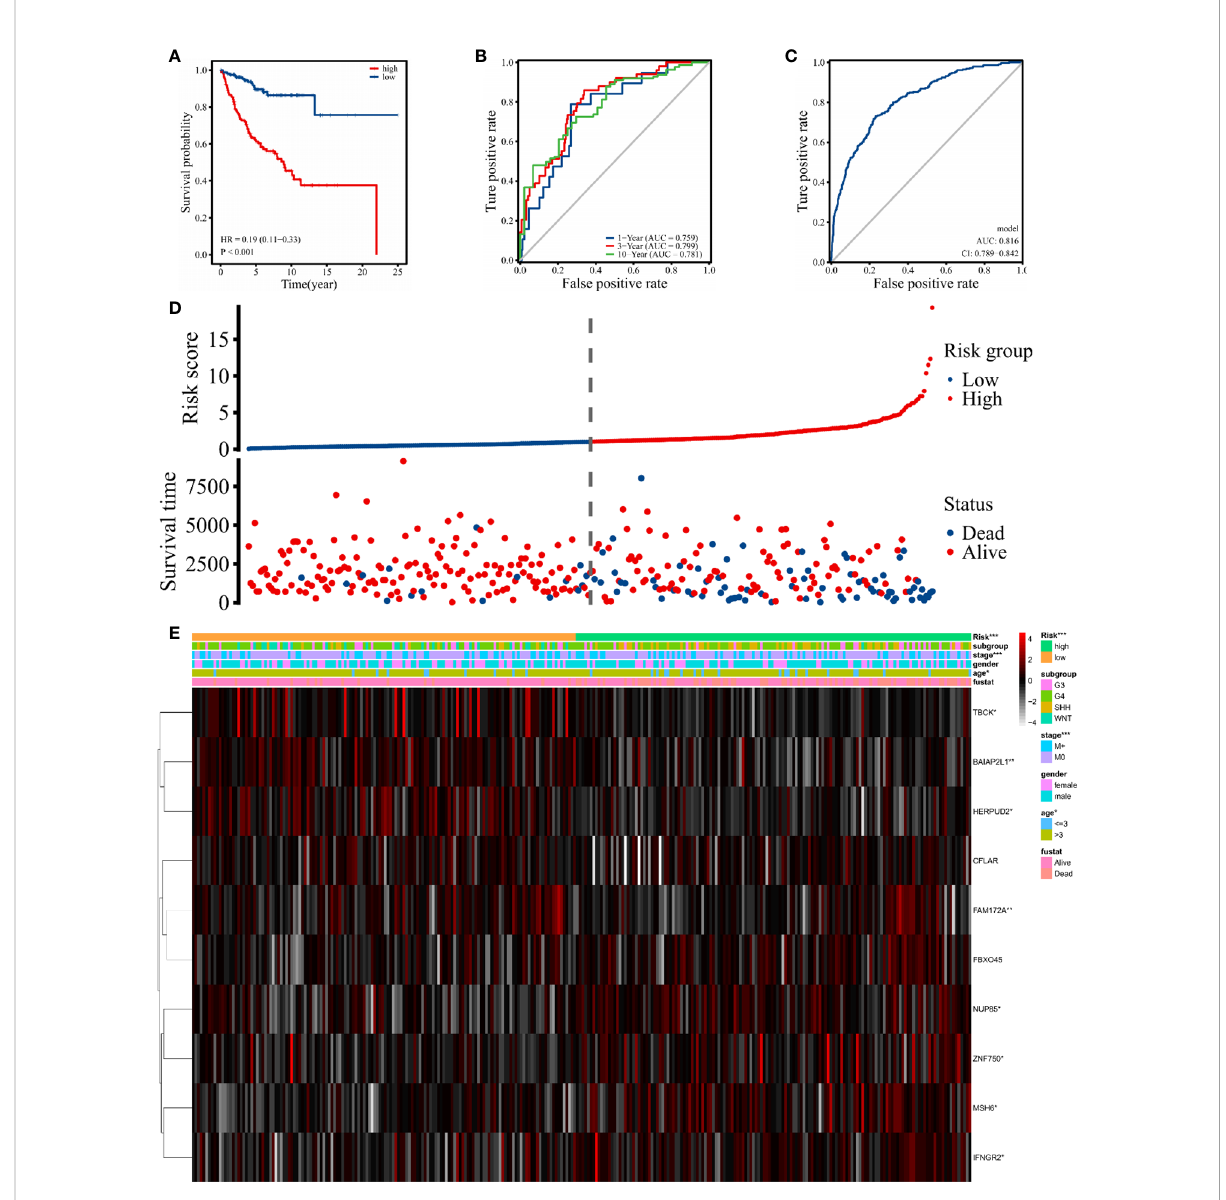
FIGURE 7 Signature-based risk score in the training cohort. (A) The Kaplan – Meier survival curves of the high (red) and low (blue) risk groups are based on the 10 hub gene signature. (B) The time-dependent ROC curves (1 year, 3 years, and 10 years) of the 10 hub gene signature. (C) ROC curve of the sensitivity for MB diagnostic through the 10 hub gene signatures. (D, E) Distribution of risk score, survival overview, and heatmap of hub genes in the training cohort. The symbol "*" means FDR adjusted p value for the labeled correlation was less than 0.05, "**" means FDR adjusted p value for the labeled correlation was less than 0.01, and "***" means FDR adjusted p value for the labeled correlation was less than